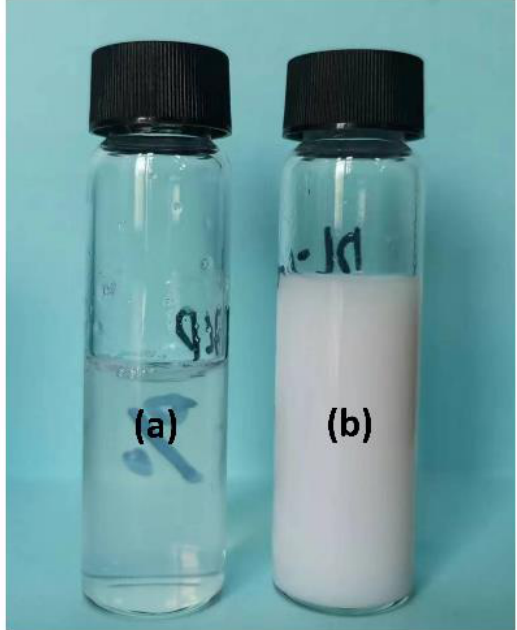
Figure 4. The dispersion status of ( a ) PS- b -PAA and ( b ) an equal amount of physically mixed PS and PAA homopolymers in water. And all polymers were pre-dissolved in DMF solvent and added dropwise into water.